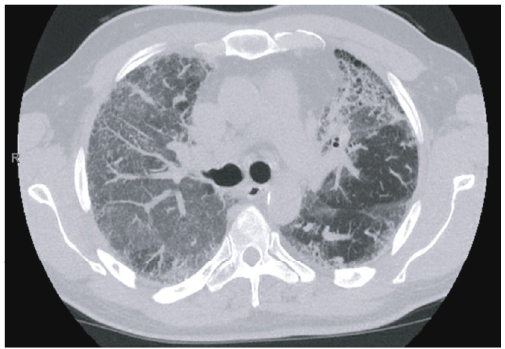
Figure 1: CT chest pretransplant (28/04/2015) demonstrating a UIP pattern of